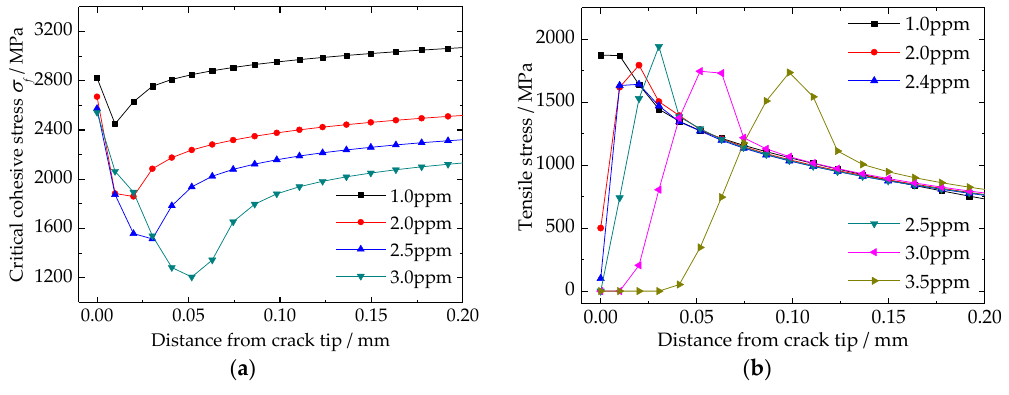
Figure 9. Distributions of critical cohesive stress and tensile stress around crack tip: ( a ) critical cohesive stress; ( b ) tensile stress.